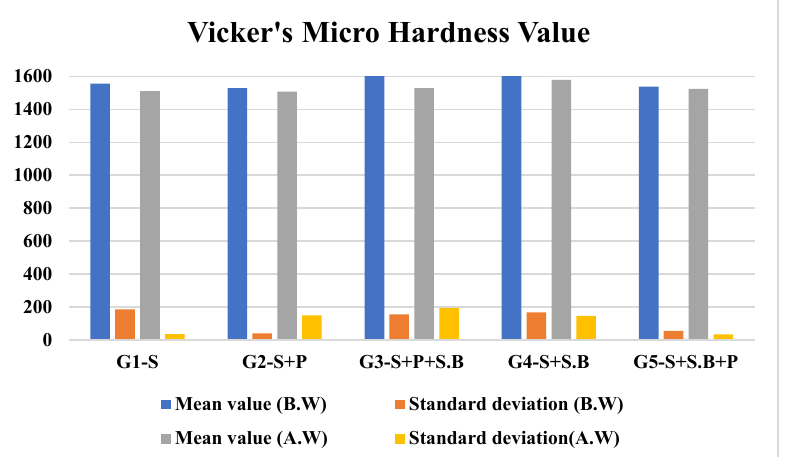
Figure 8. Vickers’s microhardness values for specimens in different groups before and after wear.